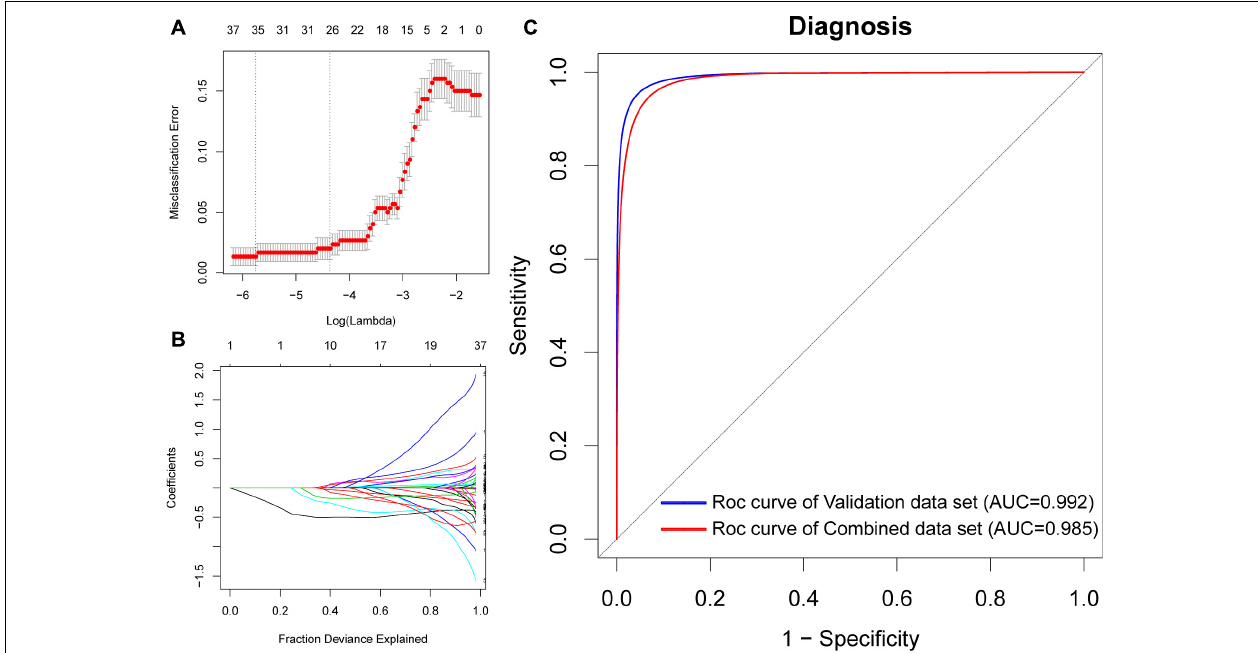
FIGURE 6 | Gene selection through the LASSO model. (A) Tenfold cross-validation for tuning parameter (lambda) selection in the LASSO regression model. The vertical lines were drawn at the optimal values by the minimum criteria and the 1 – SE criteria. (B) The LASSO coefficient profiles of the 608 DEGs. (C) ROC curve analysis of the validation dataset and combined